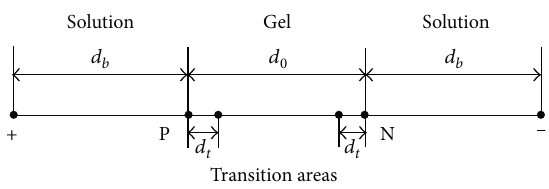
Figure 2: Computing model in one